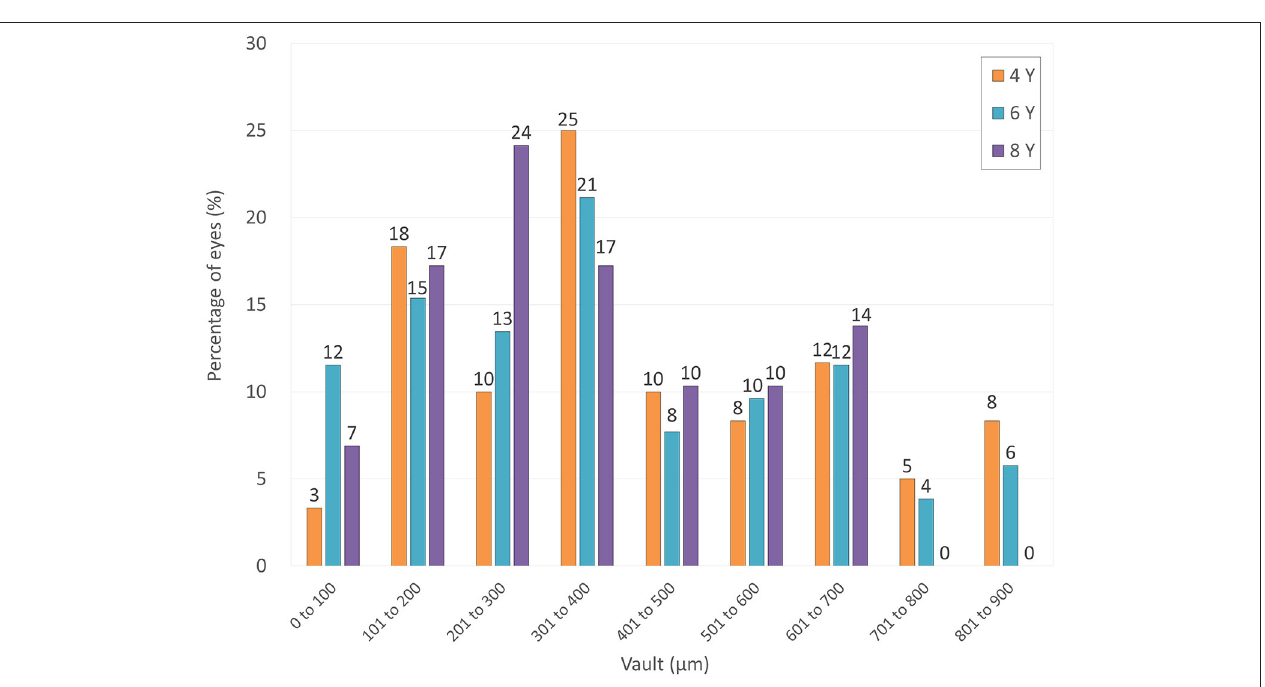
spanning 5 years or more, for the myopic study population. Concerning the conventional ICL without a central port, Moya et al. (1) stated that the spherical equivalent refraction was −